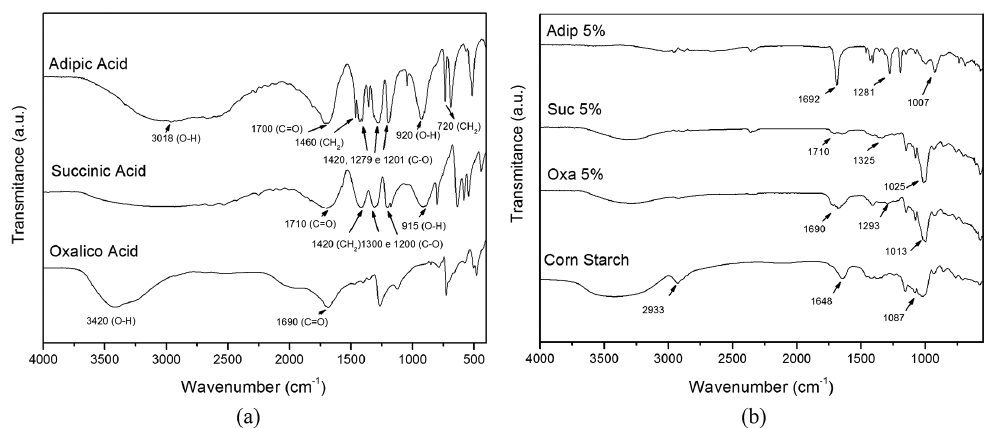
Figure 4. FTIR spectra of the precursors (a) and biofilms